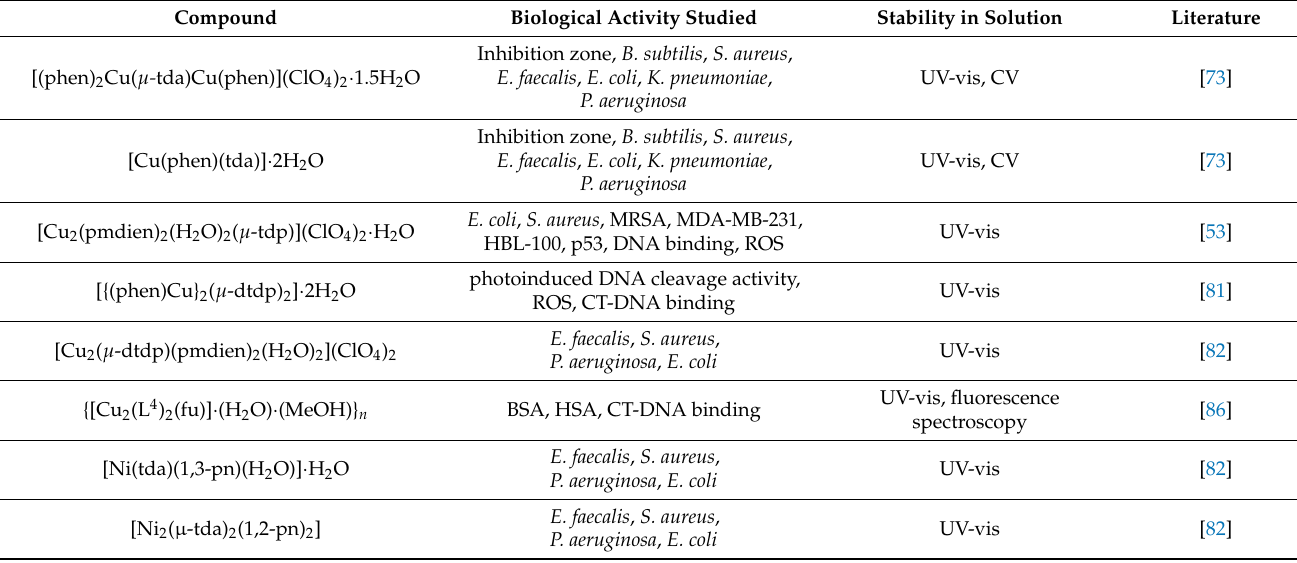
Table 10. Overview of complexes used in biological